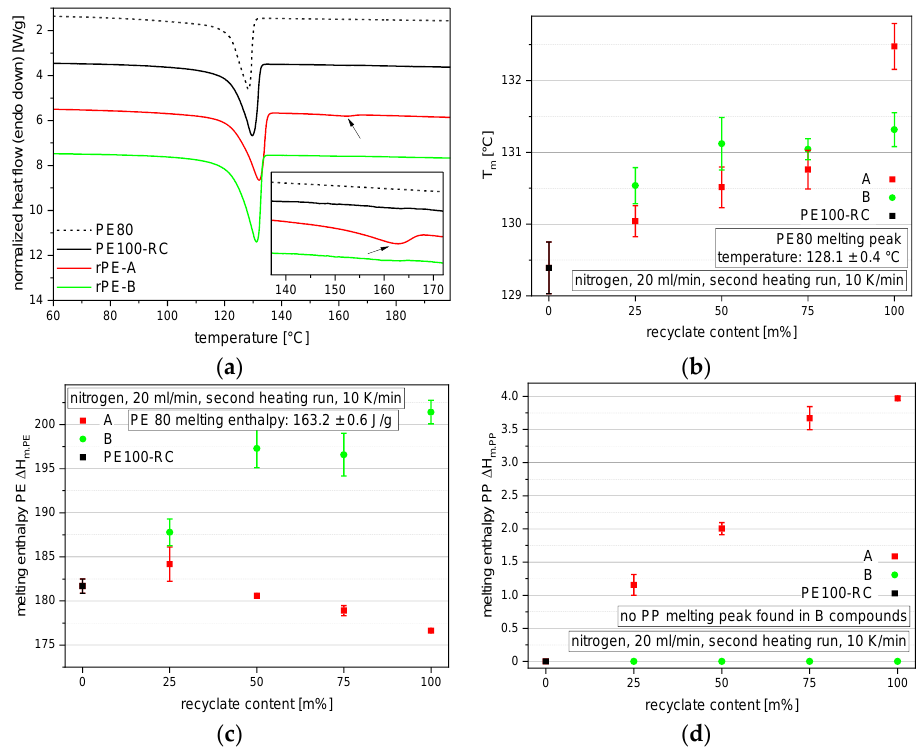
Figure 4. Graphical illustration of DSC results. Thermograms of the virgin materials and the pure recyclates are shown in ( a ). Results of all materials are shown in terms of PE melting temperatures ( b ), PE melting enthalpies ( c ), and PP melting enthalpies ( d ). The vertical bars show the sample standard deviation.